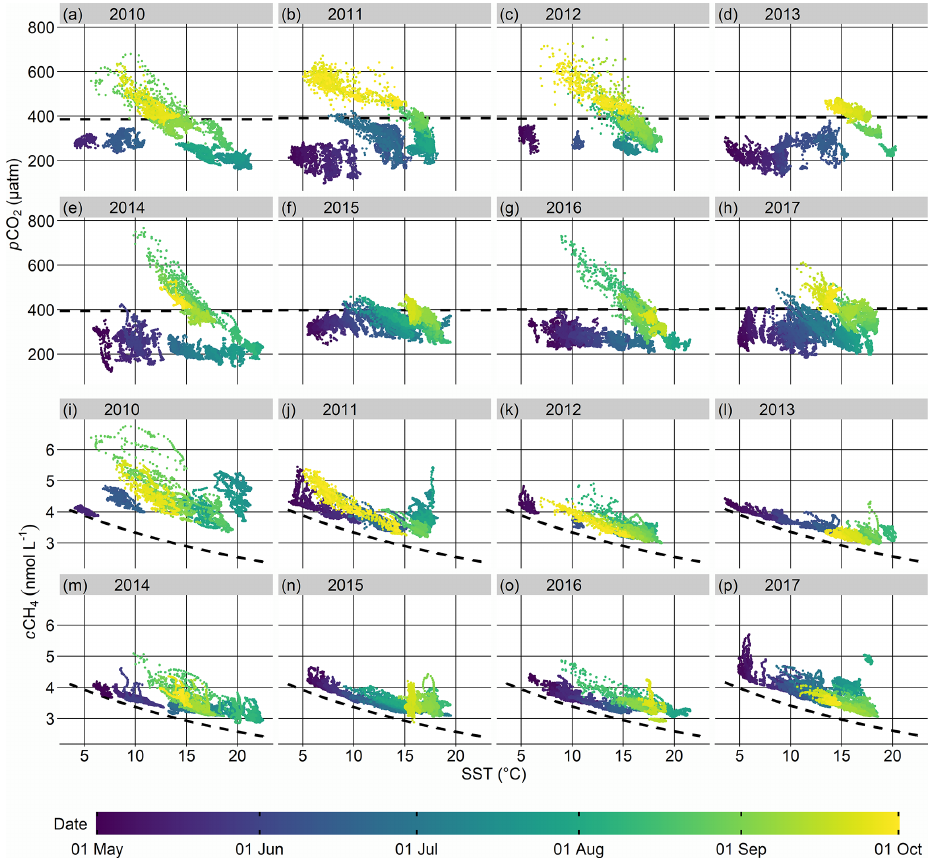
Figure 9. Surface CO 2 partial pressure (a–h) and CH 4 concentration (i–p) from 1 May to 30 September within the Ö-S box, each plotted against temperature for individual years. The measurement date is colour-coded. Dashed black lines indicate atmospheric-equilibrium partial pressure and concentration (calculated using mean seasonal salinity),